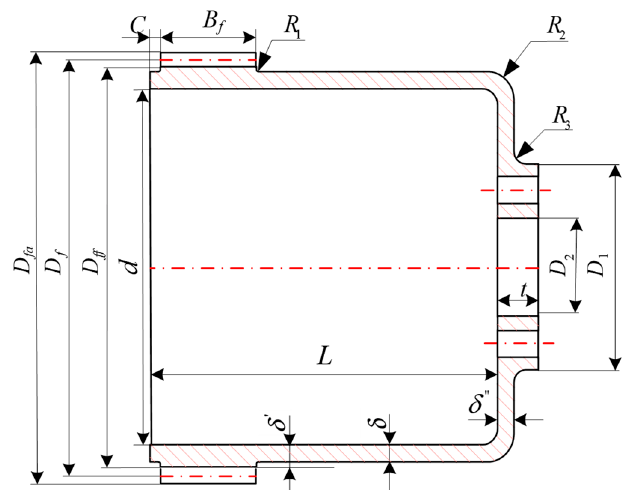
Figure 1. Structure diagram of the flexible wheel.